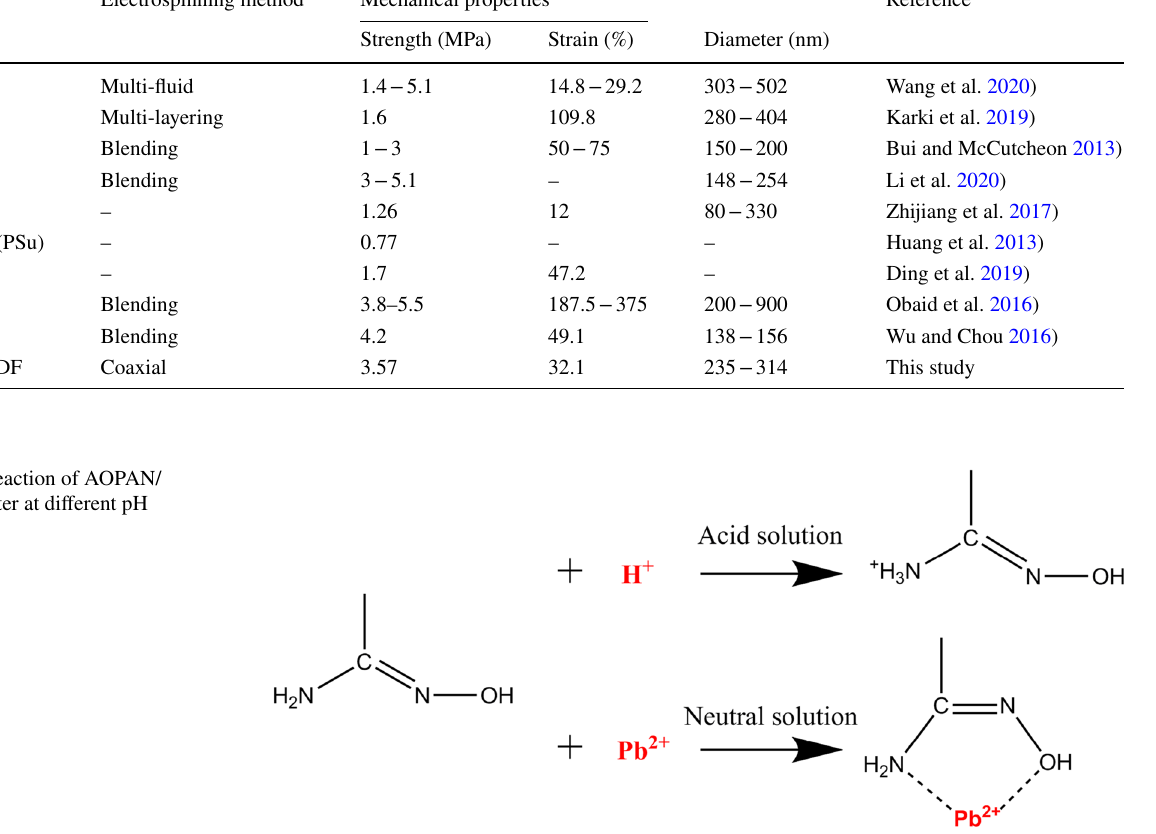
Table 4 Comparison of the mechanical properties and diameters from different researches Polymer